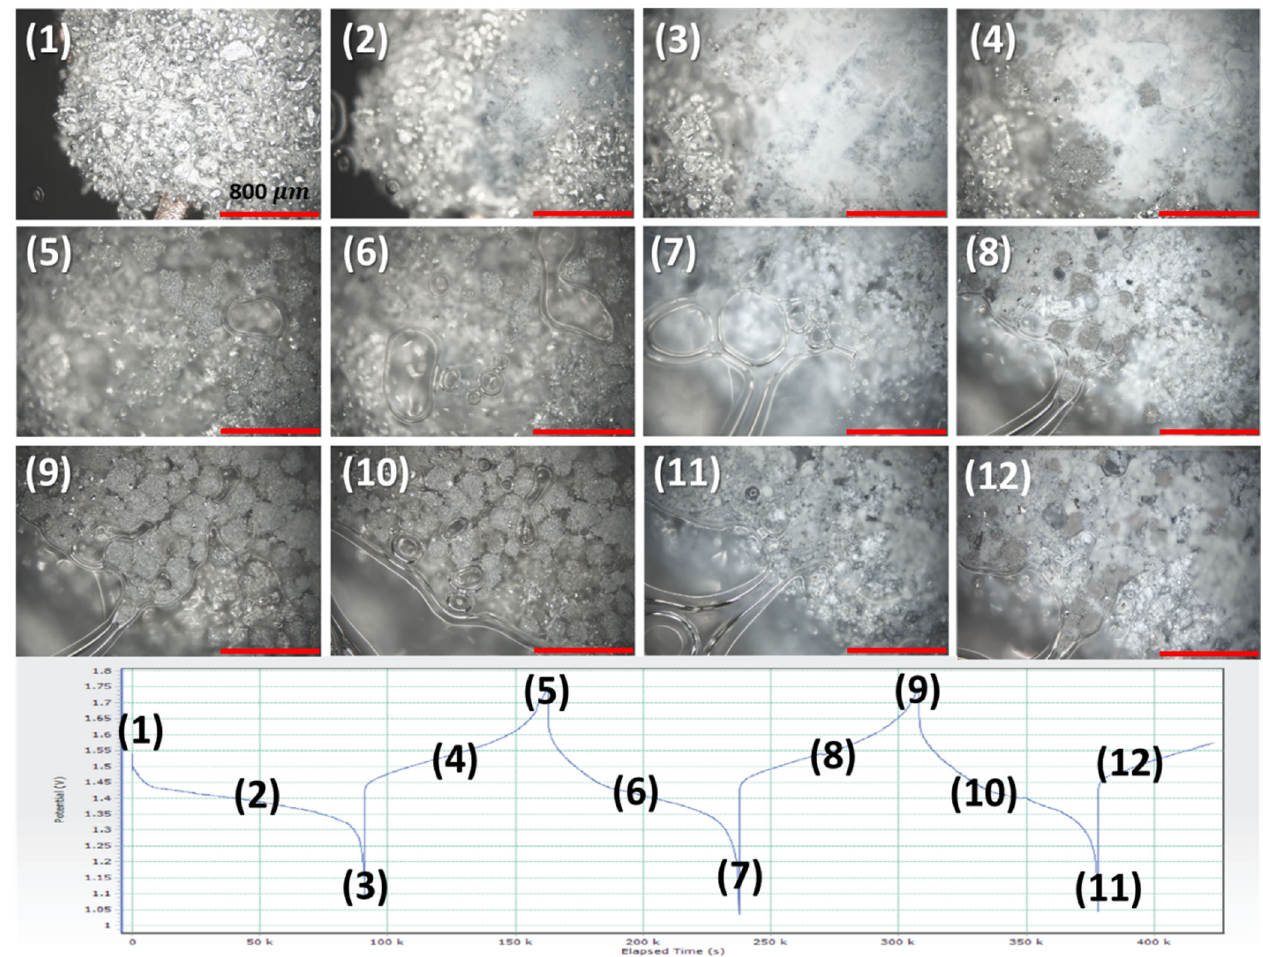
Figure 10. In operando optical microscope images of a Zn anode cycled in a hydrogel-containing Zn–MnO 2 cell. Charge–discharge curves of the cell are shown in the bottom part with numbers denoting the regions where the pictures were captured. For video, please refer to Supplementary Video S1. All images have the same scale (scale bar = 800 μ m).